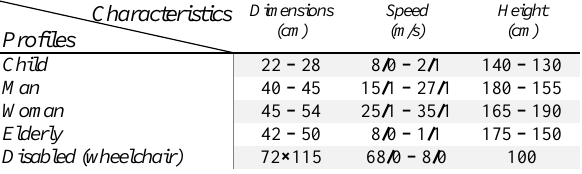
Figure 10. Diagrams of measured smoke by the sensors